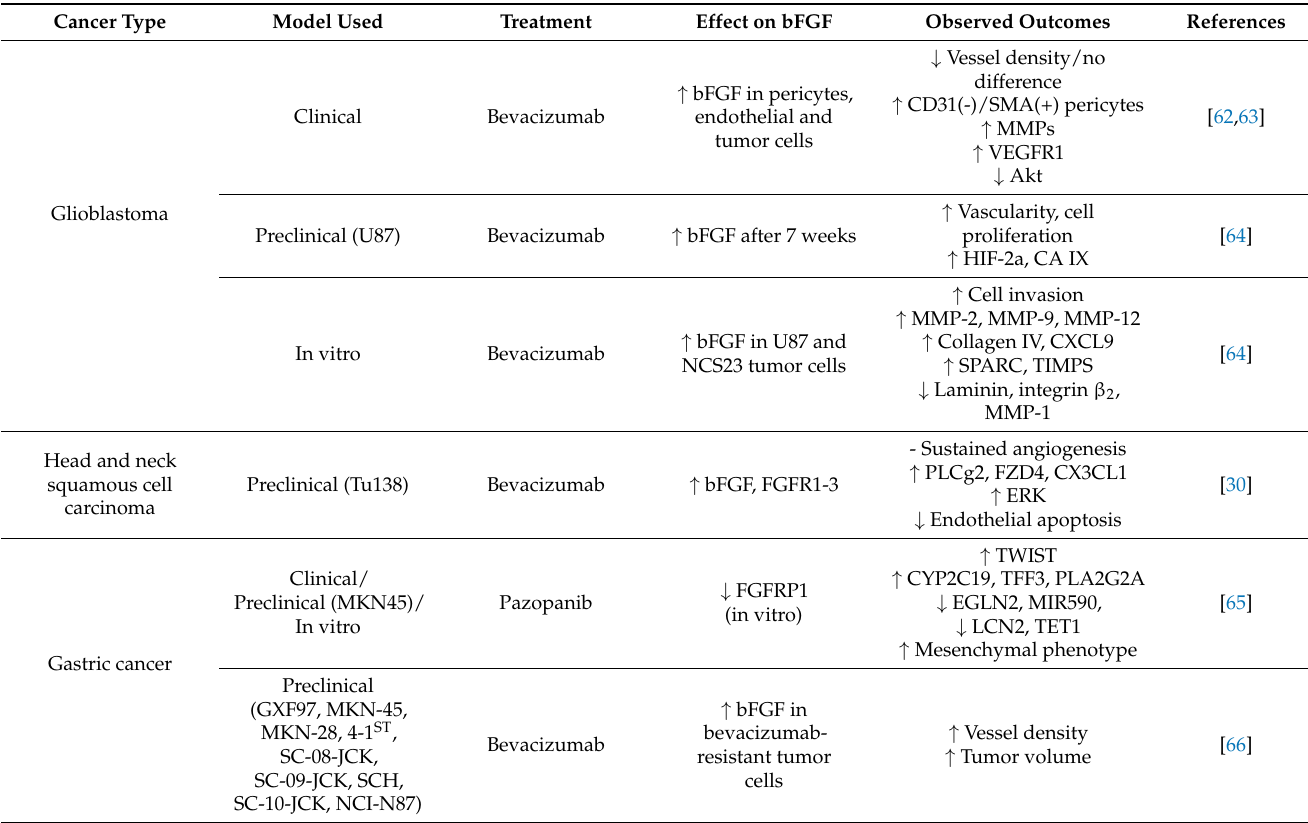
Table 1. Summary of clinical, preclinical and in vitro tumor studies demonstrating that anti-angiogenic inhibition induced basic fibroblast growth factor (bFGF) expression. The cancer type, anti-angiogenic treatment, effect in bFGF expression and observed outcomes of each study are presented. CD31: cluster of differentiation 31; SMA: smooth muscle actin; FGFR: FGF receptors; MMPs: matrix metalloproteinases; SPARC: secreted protein acidic and rich in cysteine; TIMPs: tissue inhibitors of metalloproteinases; PDGF: platelet-derived growth factor; VEGF: vascular endothelial growth factor; RIP-Tag2: rat insulin promoter-1 driven viral SV40 large T-antigen; HUVEC: human umbilical vein endothelial cells; PDGFR: platelet-derived growth factor